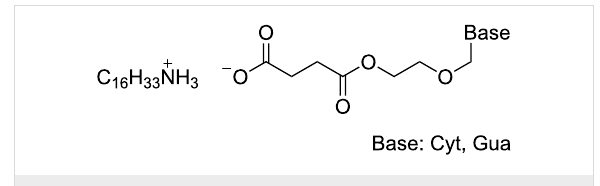
Figure 5: Materials used to prepare a smectic